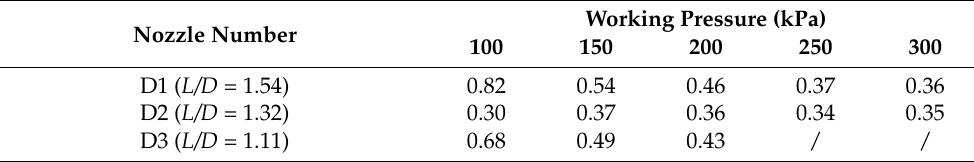
Table 4. Coefficient of variation for diamond nozzles with different L/Ds .